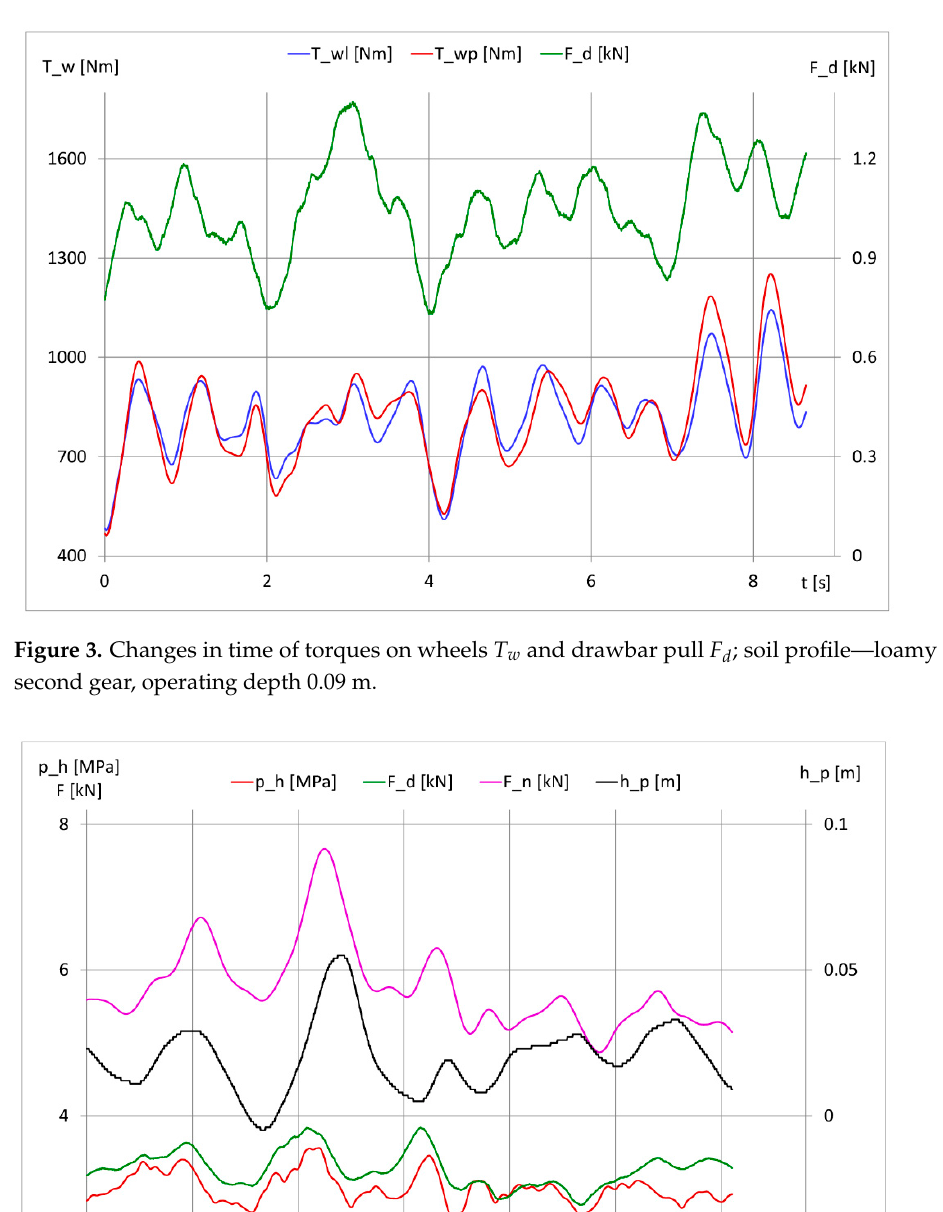
Figure 2. The scheme for placement of measurement sensors on the machine unit: 1—Flowtronic 215 fuel gauge; 2—II DICKEY-JOHN radar; 3—P8AP pressure converter; 4—LVDT implement linkage position sensor; 5—tensometer for measuring force in the upper linkage bar; 6—elasto- magnetic sensors for measuring longitudinal forces in lower linkage bars (left and right); 7—ten- someters for measuring forces in hangers (left and right); 8—PCID-4 ZN induction sensors of drive wheel angular velocity (2 pcs); 9—tensometers to measure torques of drive wheels (left and right).